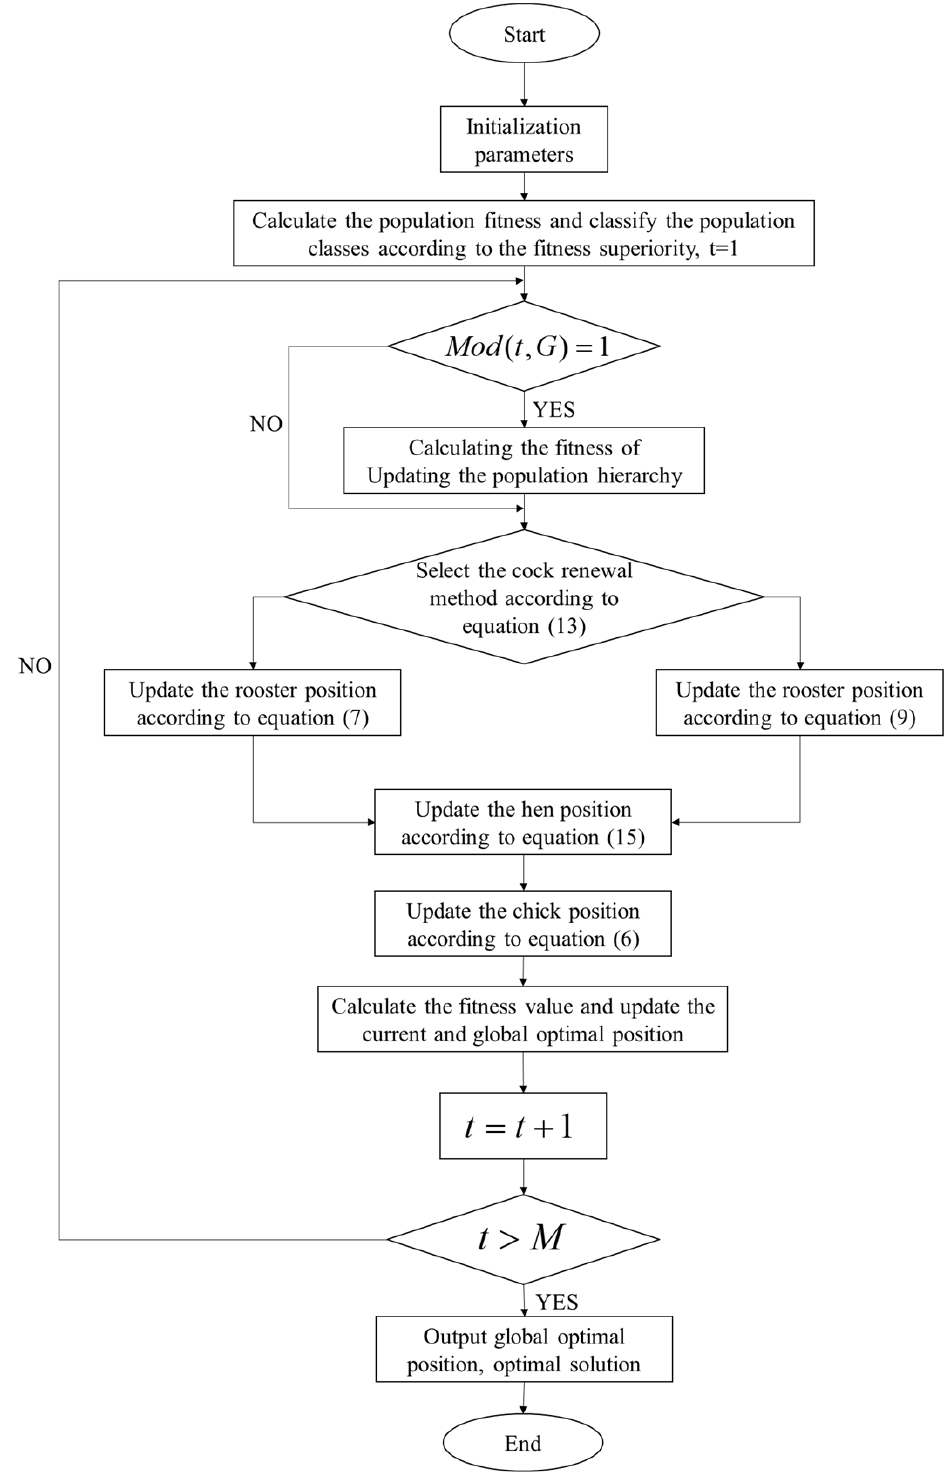
Figure 5. The fl owchart for PDCSO. Figure 5. The flowchart for Algorithm 1: Pseudocode for the PDCSO algorithm.